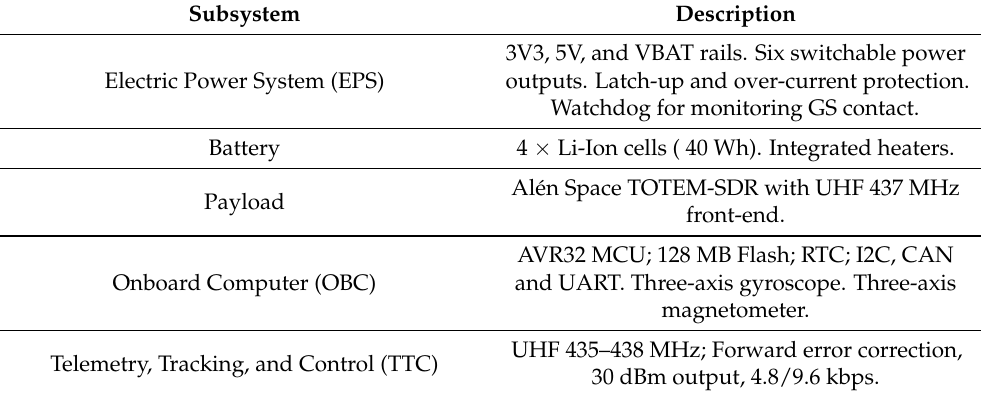
Table 2. AlfaCrux